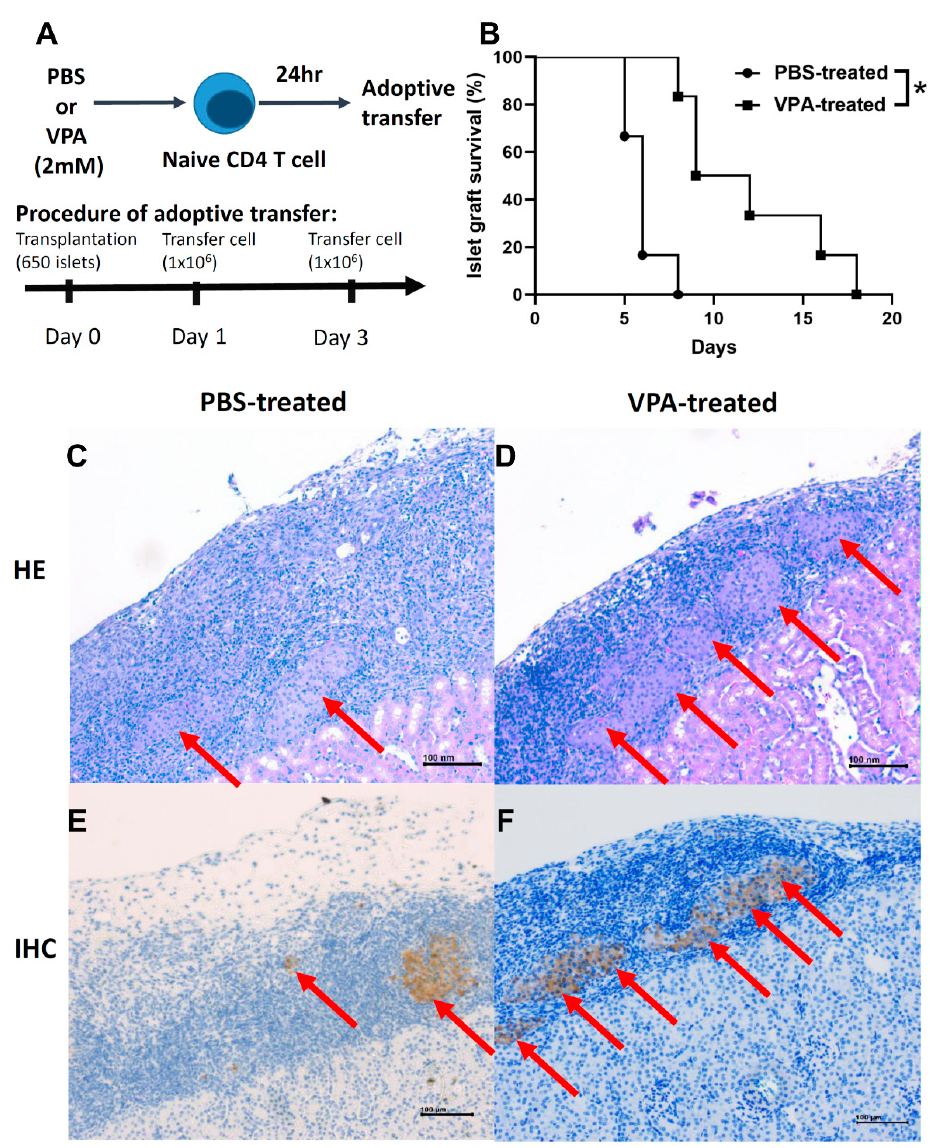
Figure 10. The effect of adoptively transferring VPA-induced Treg cells in the islet graft survival in syngeneic islet transplantation. ( A ) Naïve CD4 T cells were harvested from the spleen of the NOD mice. The naïve naive CD4 T cells were cultured in the medium with 2 mM VPA or PBS. A total of 1 × 10 6 PBS-treated or VPA-treated cells were collected and adoptively transferred into the NOD mice twice at day 1 and day 3 after islet transplantation. ( B ) The islet graft survival was significant longer in the VPA-treated group compared to the PBS-treated group (* p < 0.05; n = 6). ( C , D ) The infiltration of lymphocytes in islet grafts was lower in the VPA-treated Treg transfer into NOD recipients at day 6 post-islet transplantation. In contrast, more islet grafts were presented in the VPA-treated Treg transferred NOD recipients. The secretion of insulin was assessed by immunohistochemical staining. Red arrow indicates the insulin staining in the ( E ) PBS-treated group and the ( F ) VPA-treated Treg transferred NOD recipients.